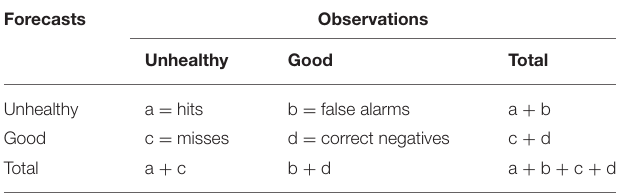
TABLE 1 | A 2 × 2 contingency table for forecast skill. Forecasts